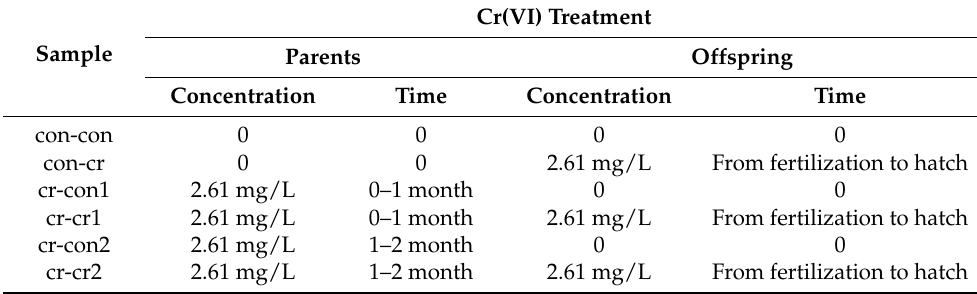
Table 1. Samples for studying transgenerational effects of